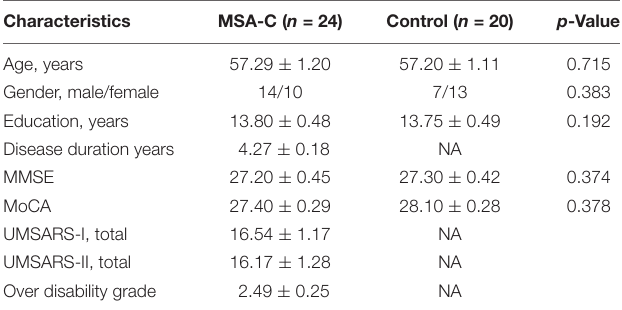
TABLE 1 | Demographic and clinical characteristics of the